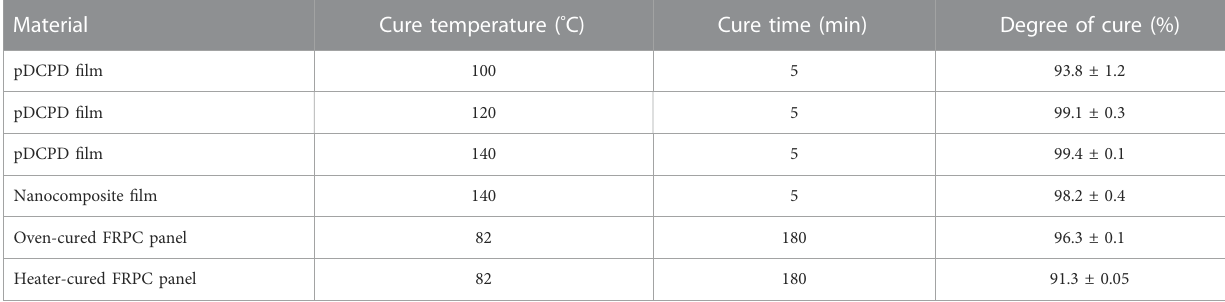
TABLE 1 Degree of cure of various samples measured using DSC